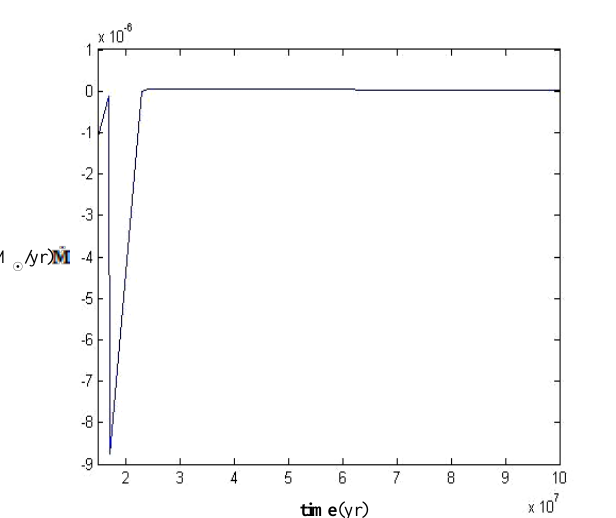
time Fig.6: The relation between and time in binary star system (13.6+8) M 